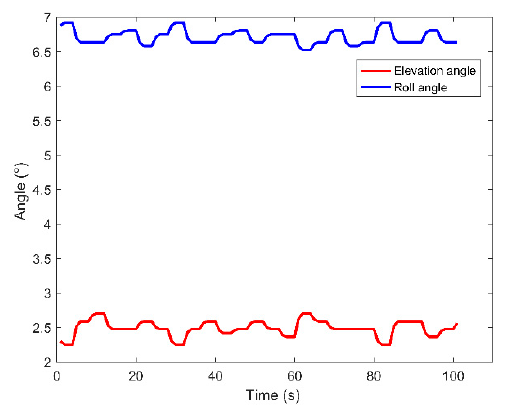
Figure 10. Experiment configuration.